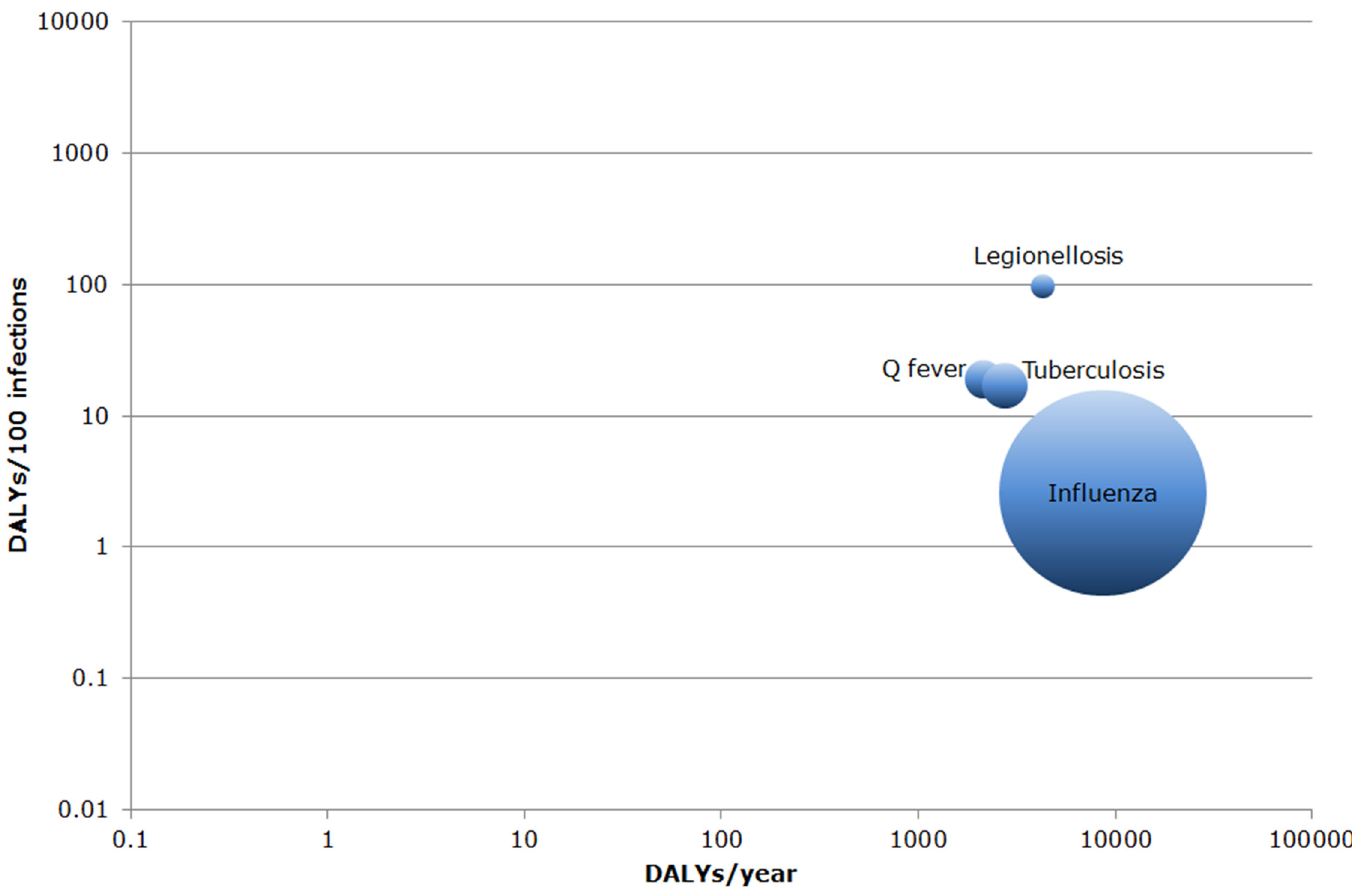
Fig 8. Ranking of respiratory diseases by disease burden at population/individual level in the Netherlands in 2007 – 2011. The area of each bubble is proportional to the average number of estimated annual cases. Both axes are on a logarithmic scale. (DALY = Disability-Adjusted Life Years, population level = number of DALYs/year, individual level = number of DALYs/100